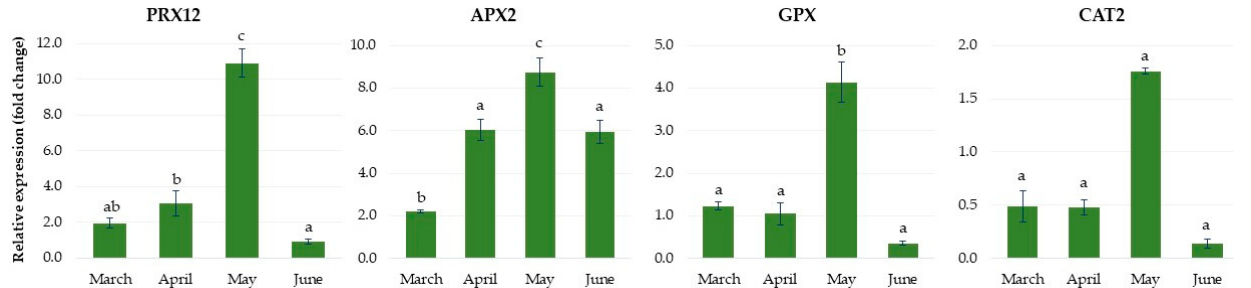
Figure 13. The relative expression of the genes involved in abscisic acid metabolism in rhubarb ‘Raspberry’ plantlets during ex vitro growth in the greenhouse from early March to the end of June. According to Duncan’s test ( p = 0.05), means marked with the same letter do not differ significantly ( p = 0.05). Error bars represent standard deviation.